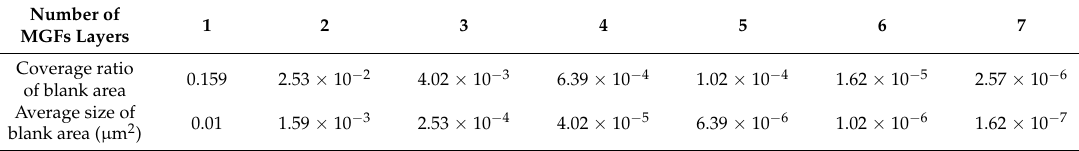
Figure 7. ( a ) Schematics of the MGFs deposited by the DSA process; and ( b ) an ultrathin closed membrane composed of a triple layer of MGFs. Table 1. The percentage of blank areas in membranes consisting of MGFs and multilayers of MGFs, and the average size of the blank areas within multilayers of MGFs.